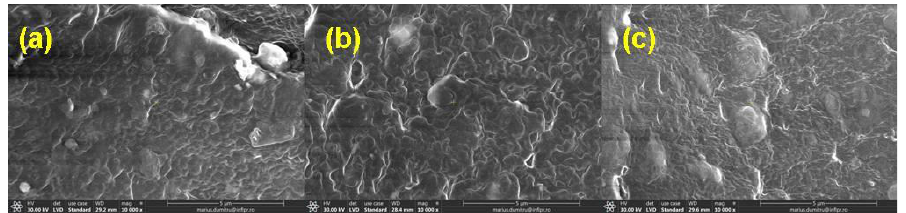
Figure 6. SEM micrographs of mixture A at magnification of 10,000: ( a ) non-irradiated and irradiated at ( b ) 150 kGy and ( c ) 450 kGy.